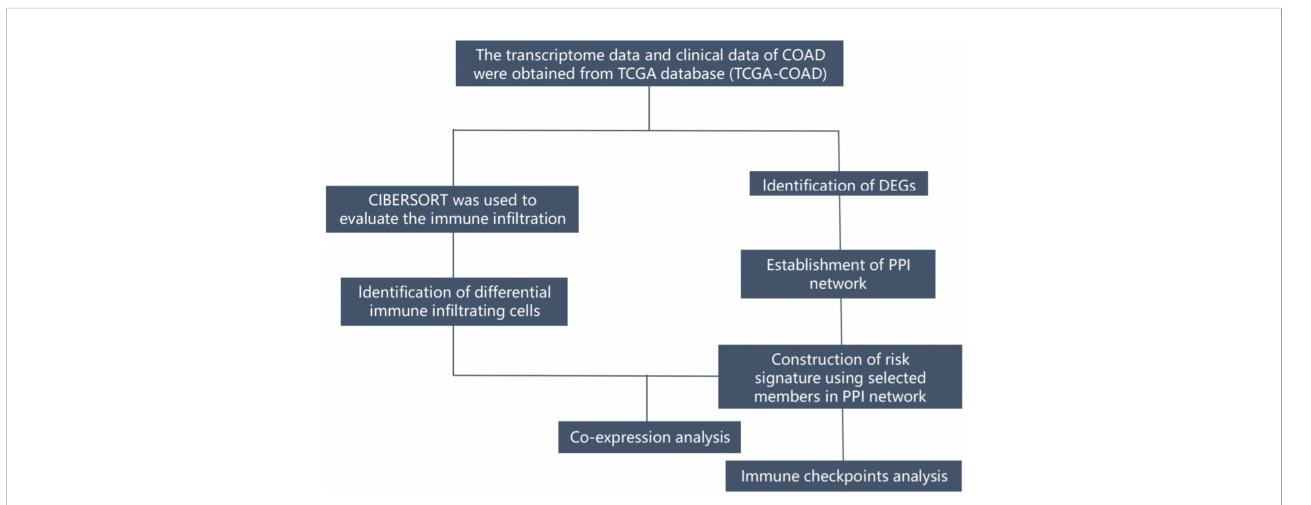
FIGURE 1 The fl ow diagram of the present study. COAD, colon adenocarcinoma; DEGs, differentially expressed genes; TCGA, The Cancer Genome Atlas; PPI, ptotein-protein interaction;.